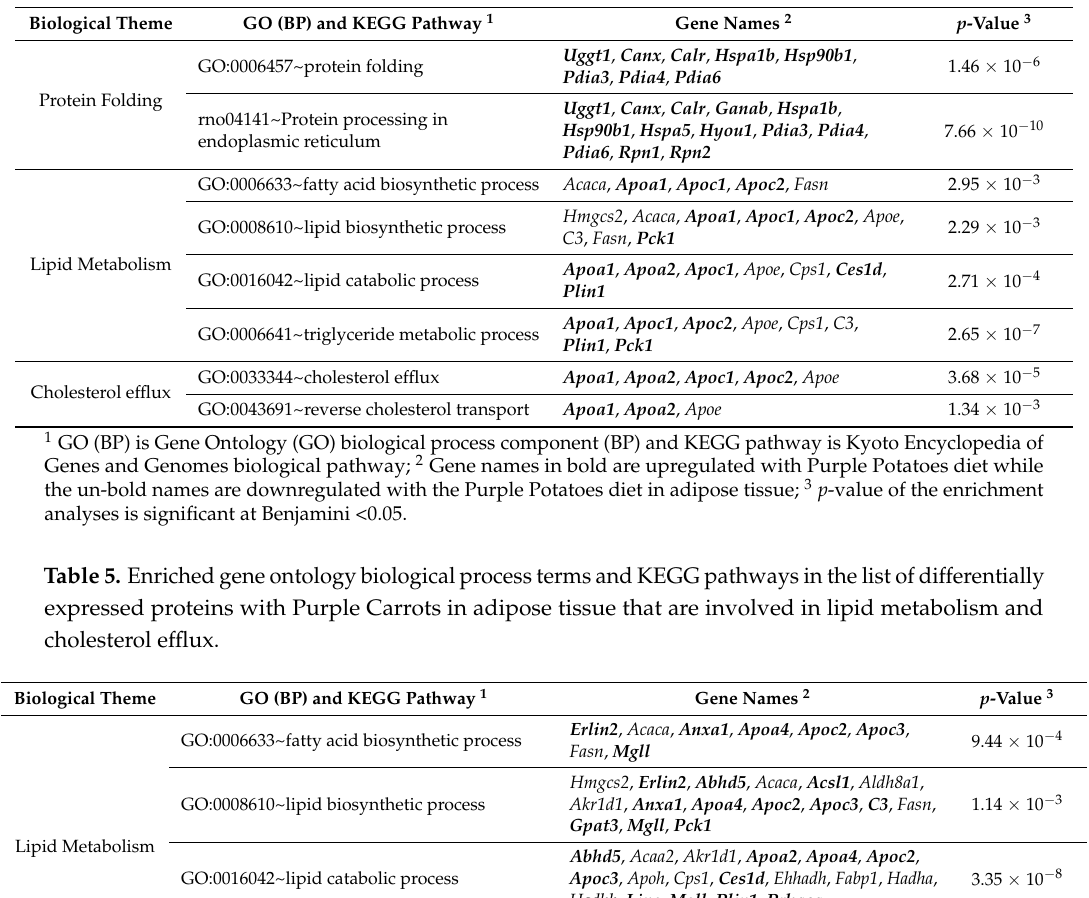
Table 4. Enriched gene ontology biological process terms and KEGG pathways in the list of differentially expressed proteins with Purple Potatoes in adipose tissue that are involved in protein folding, lipid metabolism and cholesterol efflux.